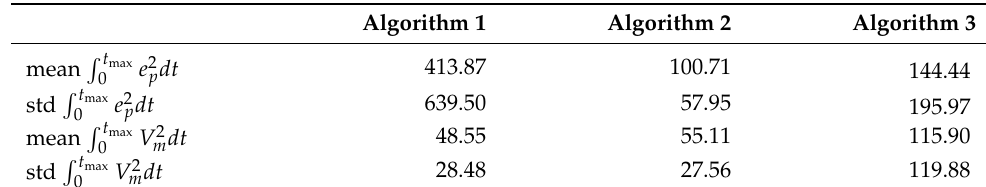
Table 2. Control law comparison.